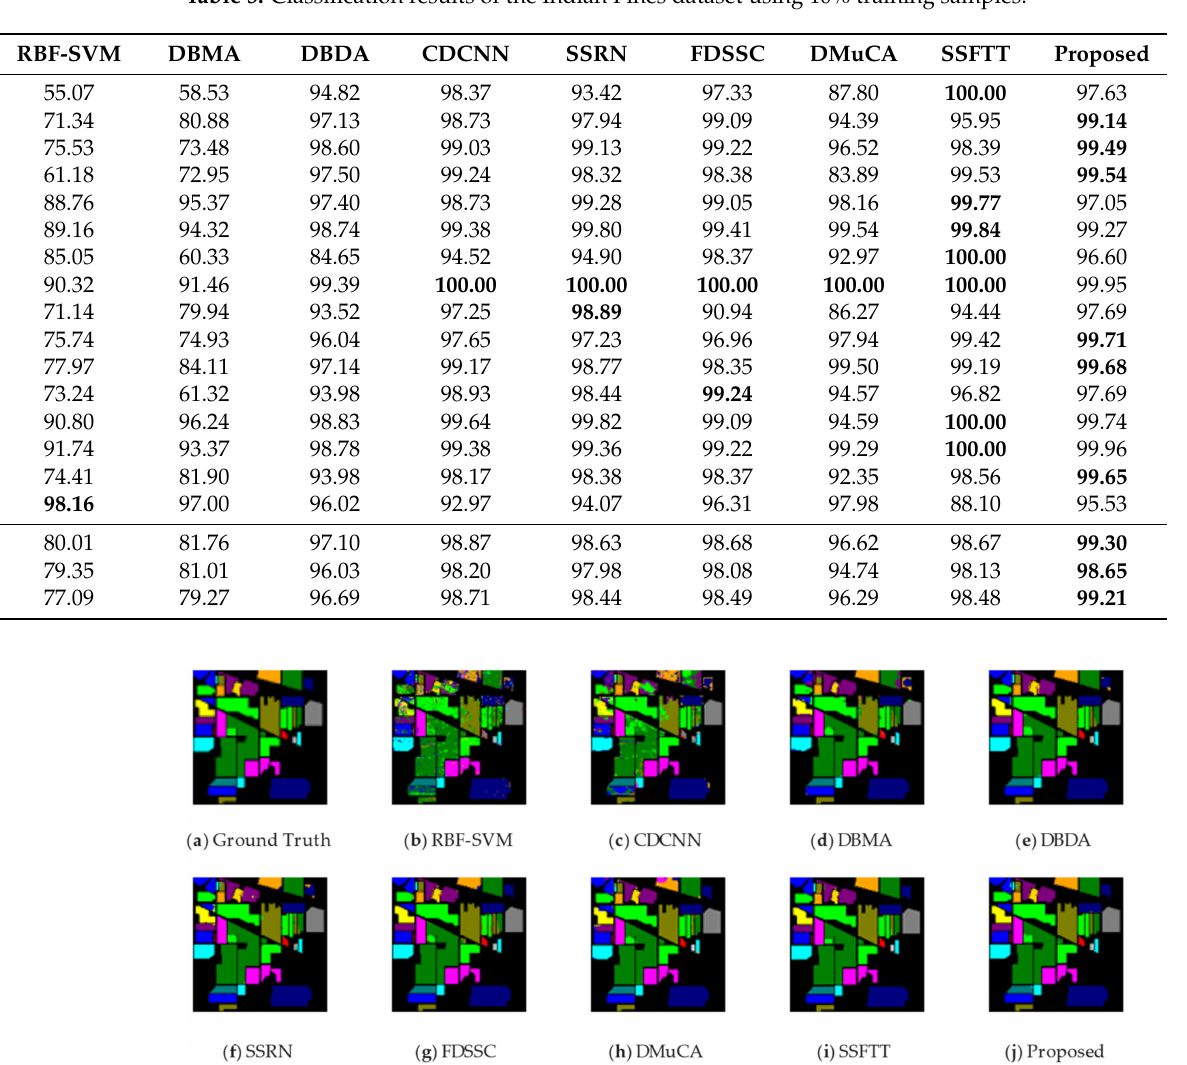
Table 5. Classification results of the Indian Pines dataset using 10% training samples.